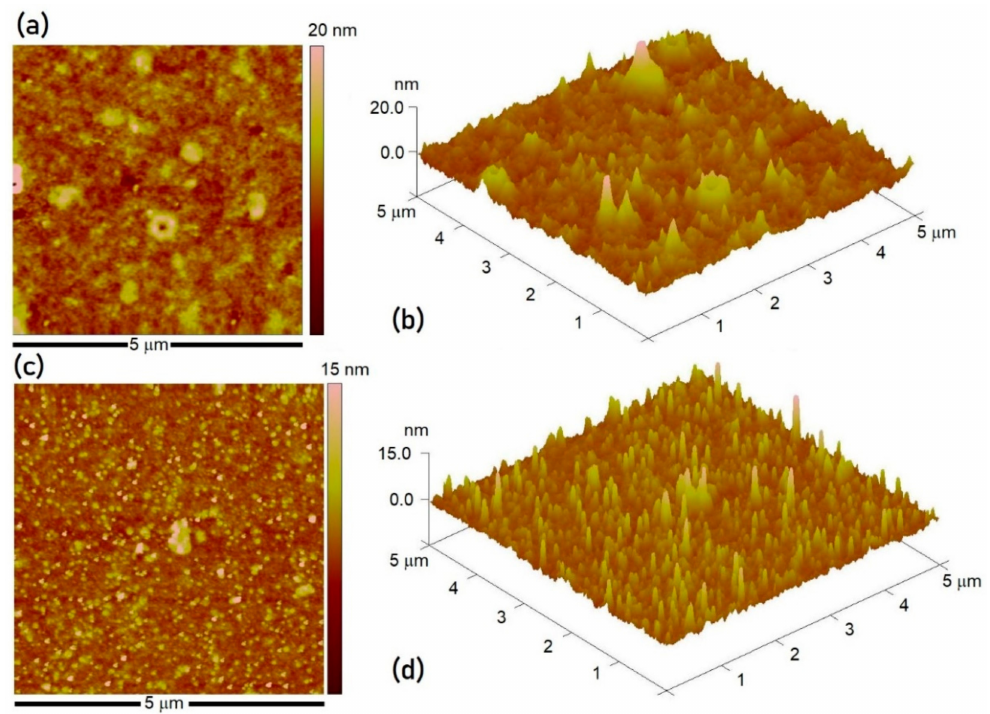
Figure 3. 2-D and 3-D AFM scans showcasing the effect of Nafion membrane deposition process on the film morphology and the NP size and distribution after indirect EC reduction for the ( a , b ) dip coating (sample S 2 ) and ( c , d ) spin coating (sample S 3 )